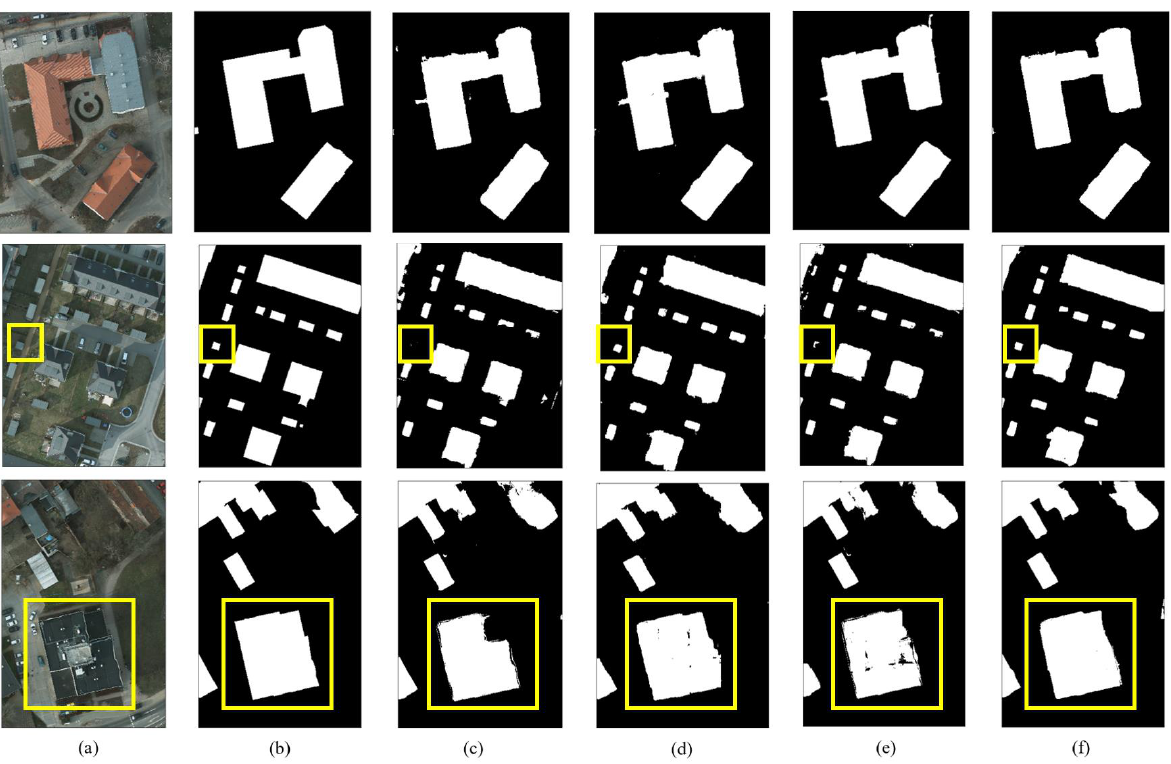
Figure3. The building extraction maps of Images from Potsdam data. (a) Original image. (b) Ground truth. Extracted building map